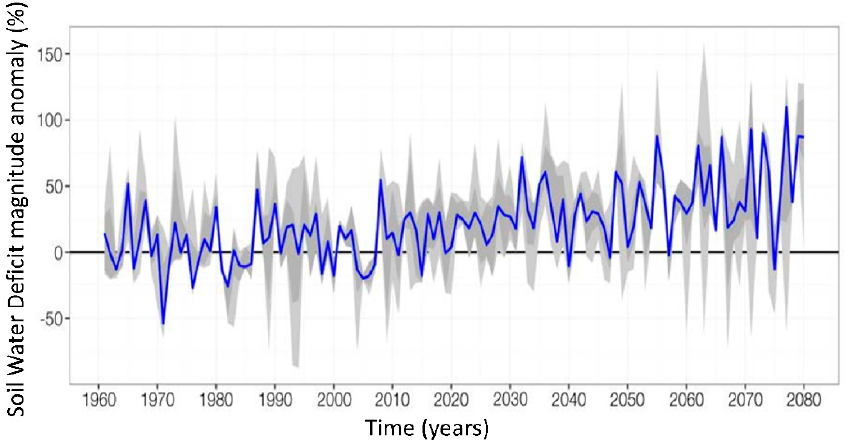
Figure 1. Water demand of the agricultural sector from 1980 to 2080 in relation to the soil water content deficit [2]. Reproduced with permission from Buffa and Ricciardi, 2017 [2].